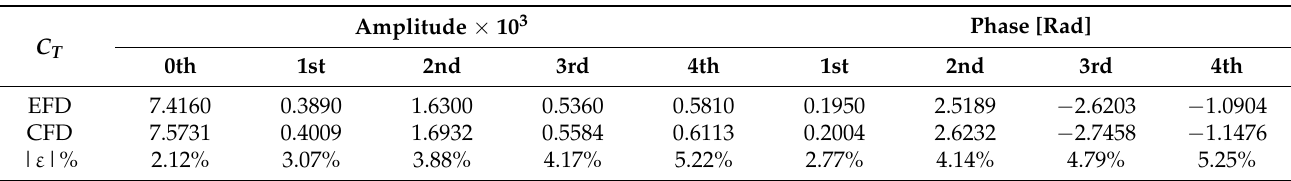
Table 14. Harmonic amplitudes and phases of the total resistance coefficient ( C T ) for the FRxz ϕθ beam waves